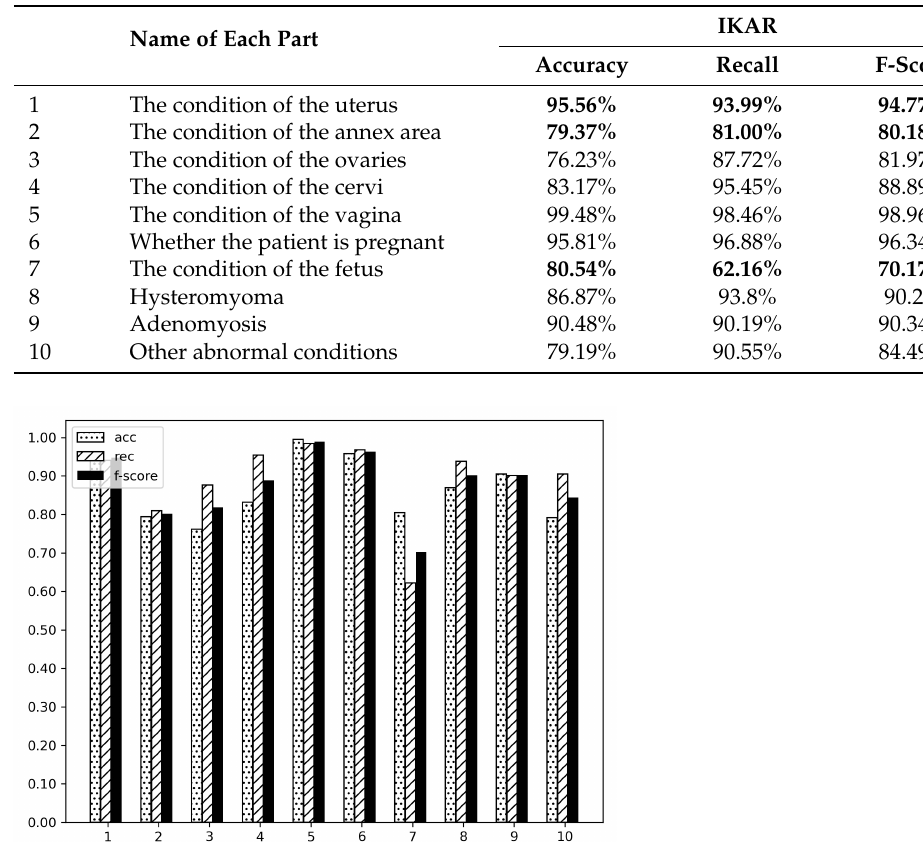
Table 9. Accuracy, recall and F-score of our model for each part.